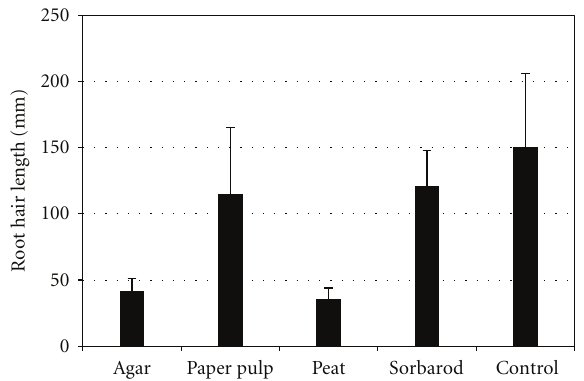
Figure 4: Root hair length in the di ff erent substrates in vitro . Con- trol: root hair of the nemesia cultivated in peat in greenhouse con- ditions. Data are mean ± s.e., n = 30.